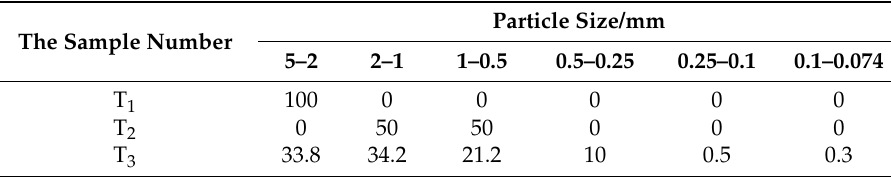
Table 1. Initial particle size distribution of soil samples